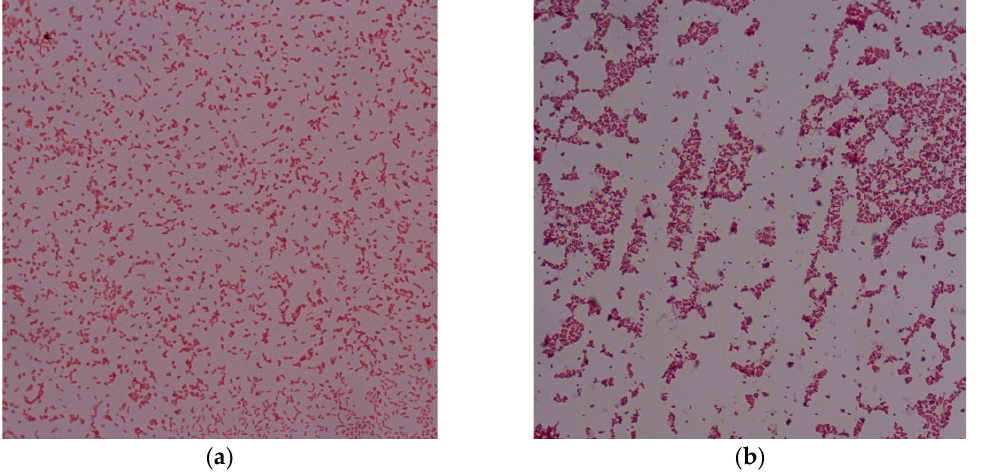
Figure 4. ( a ) Bacteria M1, negative bacteria and ( b ) bacteria M2, positive bacteria. Both bacteria were isolated from the mouth. Table 7. Minimum inhibitory concentration (MIC) and minimum bactericidal concentration